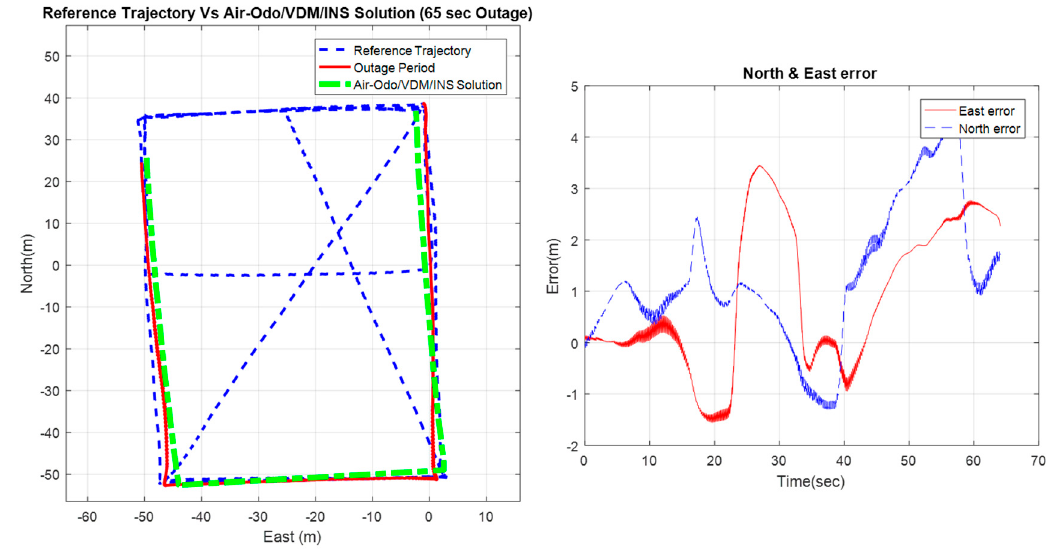
Figure 14. Air-Odo/Vehicle Dynamic Model/INS integration performance during 65 of complete GNSS signal outage, Air-Odo for velocity update, and VDM for heading constraint.